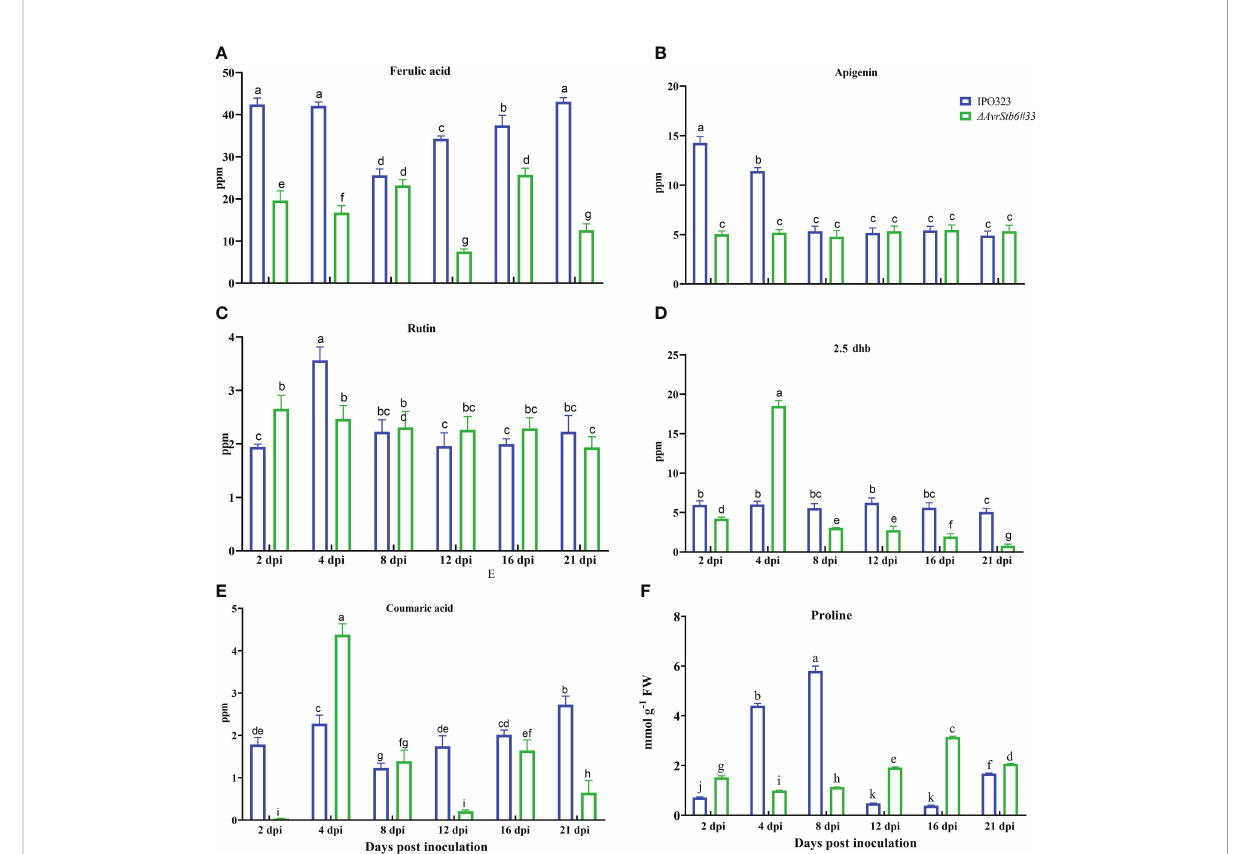
FIGURE 8 AvrStb6-Stb6 interaction orchestrates the activities of six non-enzymatic antioxidant agent: (A) Ferulic acid, (B) Apigenin, (C) Rutin, (D) 2,5- Dihydroxybenzoic aci (2.5 dhb), and (E) coumaric acid, and (F) Proline. Data are indicate as mean ± SD (Standard Deviation) of four biological samples from one independent experiment. Different lowercase letters indicate statistically signi fi cant differences (P ≤